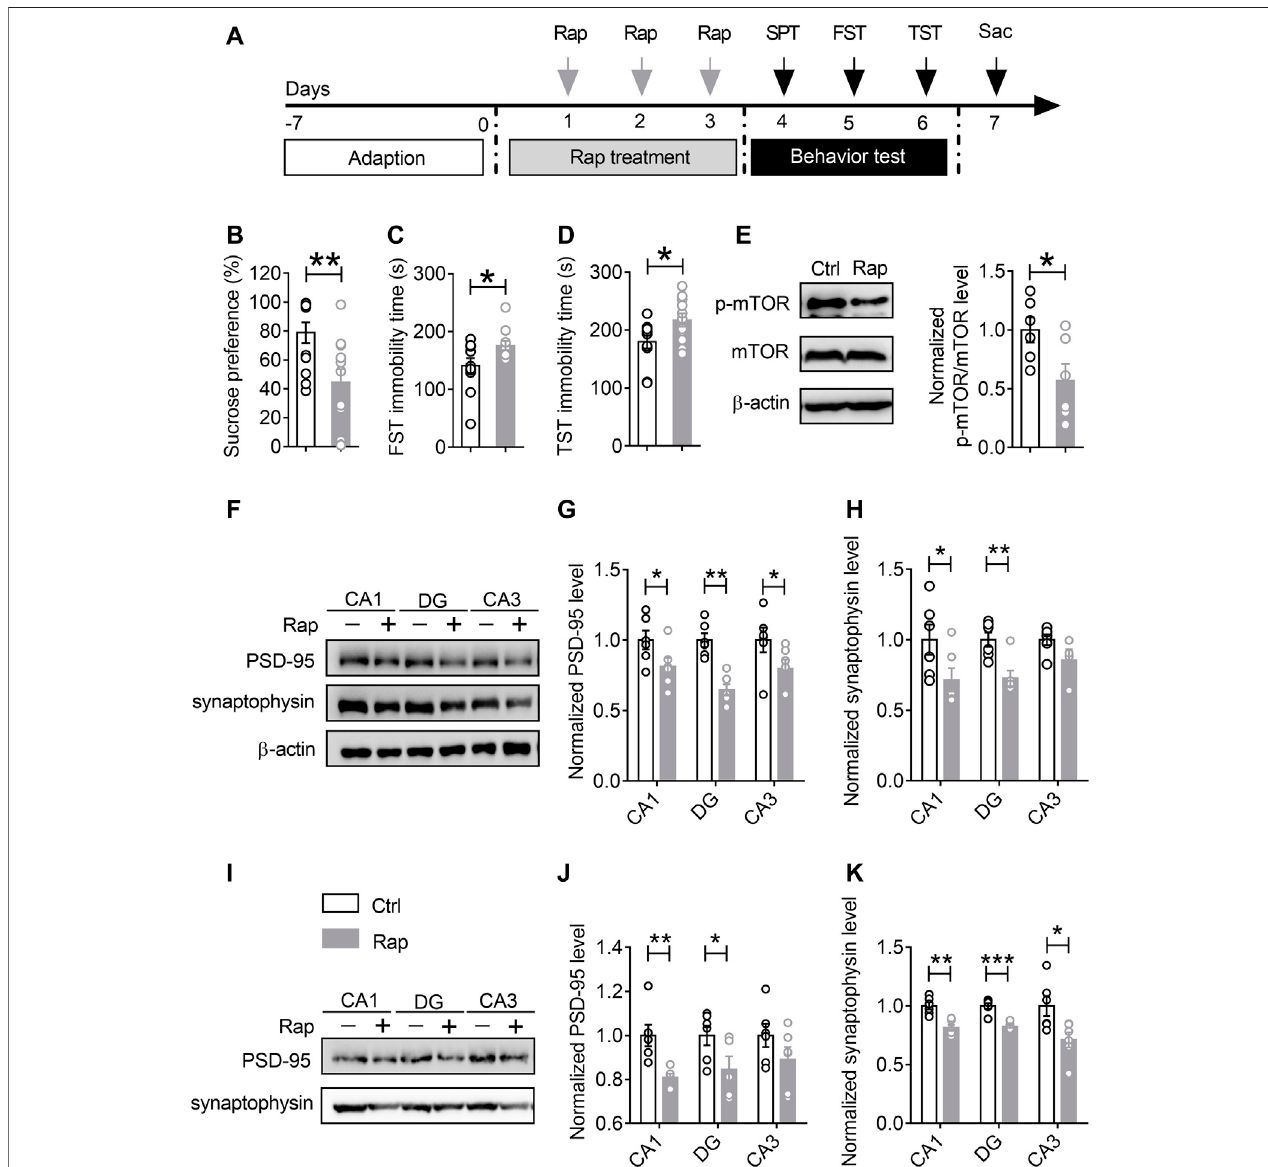
FIGURE 5 | Treatment with rapamycin induces depression-like behaviors and synapse loss in the ventral hippocampus. (A) The schematic timeline of the experimentalprocedures. (B – D) Intracerebroventricularinfusionofrapamycinsimulateddepression-likebehaviors,includingreducedsucrosepreferenceintheSPT (B) , increased immobile time in the TST (C) , and increased fl oating time in the FST (D) . (E – H) Rapamycin injection decreased mTOR activity in the vHIP (E) , as well as the expression of PSD-95 and synaptophysin in the CA1, DG and CA3 of vHIP; representative Western blots (F) , statistical analysis of PSD-95 (G) and synaptophysin (H) . (I – K) Rapamycin treatment induced synapse loss in the CA1, DG and CA3 of vHIP; representative Western blots (I) , statistical analysis of PSD-95 (J) and synaptophysin (K) .Dataarepresentedasmean ± SEM.One-wayANOVAforall.n (cid:1) 11pergroupfor (B – D) ; n (cid:1) 6pergroupfor (E,G,H,J,K) .* p < 0.05,** p < 0.01,*** p < 0.001 vs. Ctrl